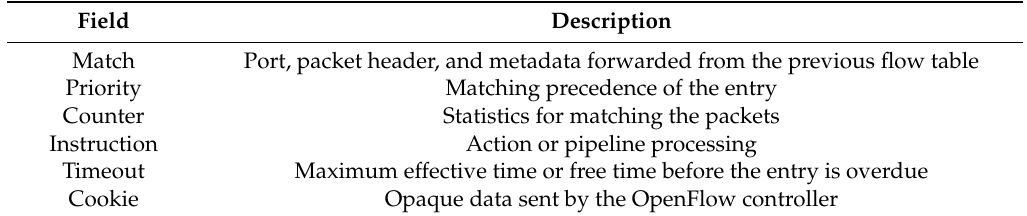
Table 1. The fields of a flow entry in the flow table.